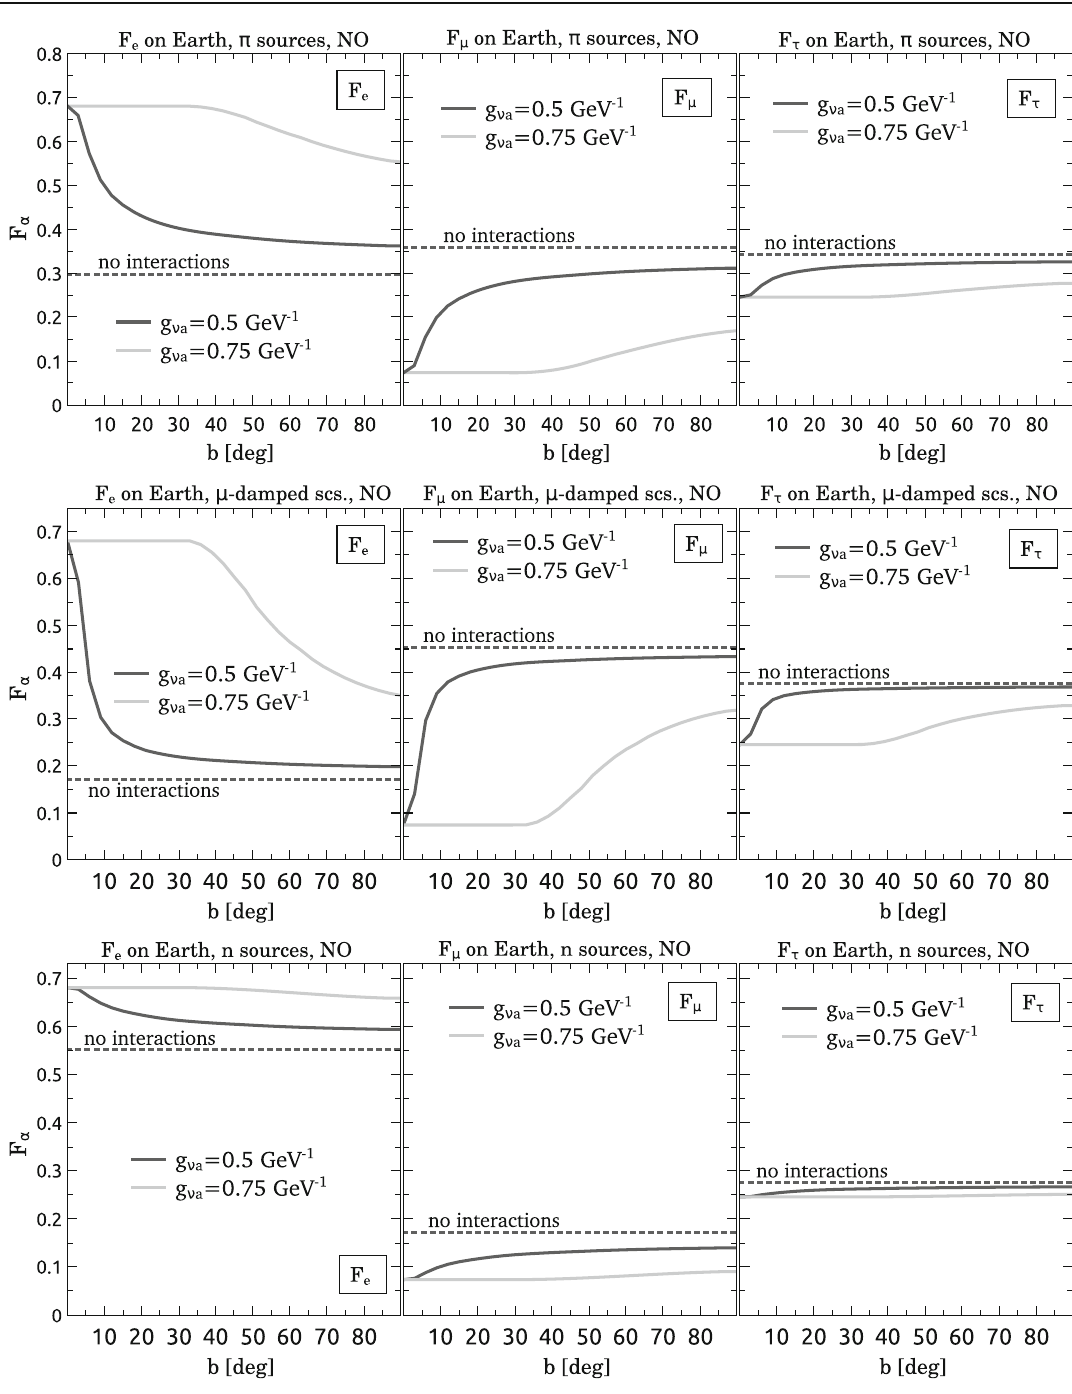
vor ratios are shown in the left, middle, and right panels, respectively. Top panels correspond to pion decay sources, middle panels to muon damped sources, and bottom panels to neutron decay